Question: State the chart type depicted above.
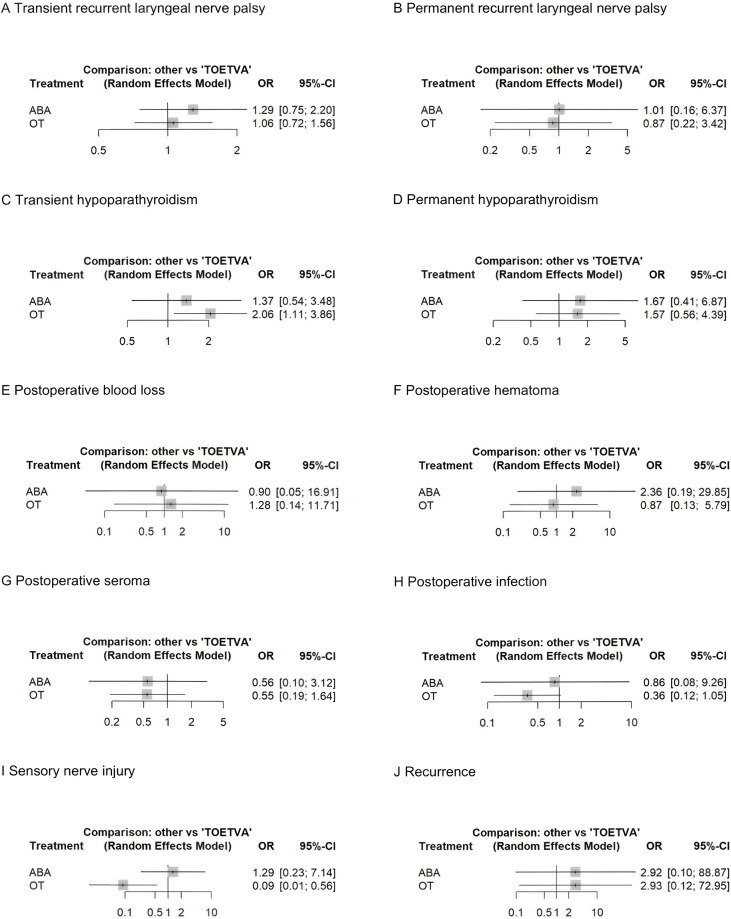
Answer: forest